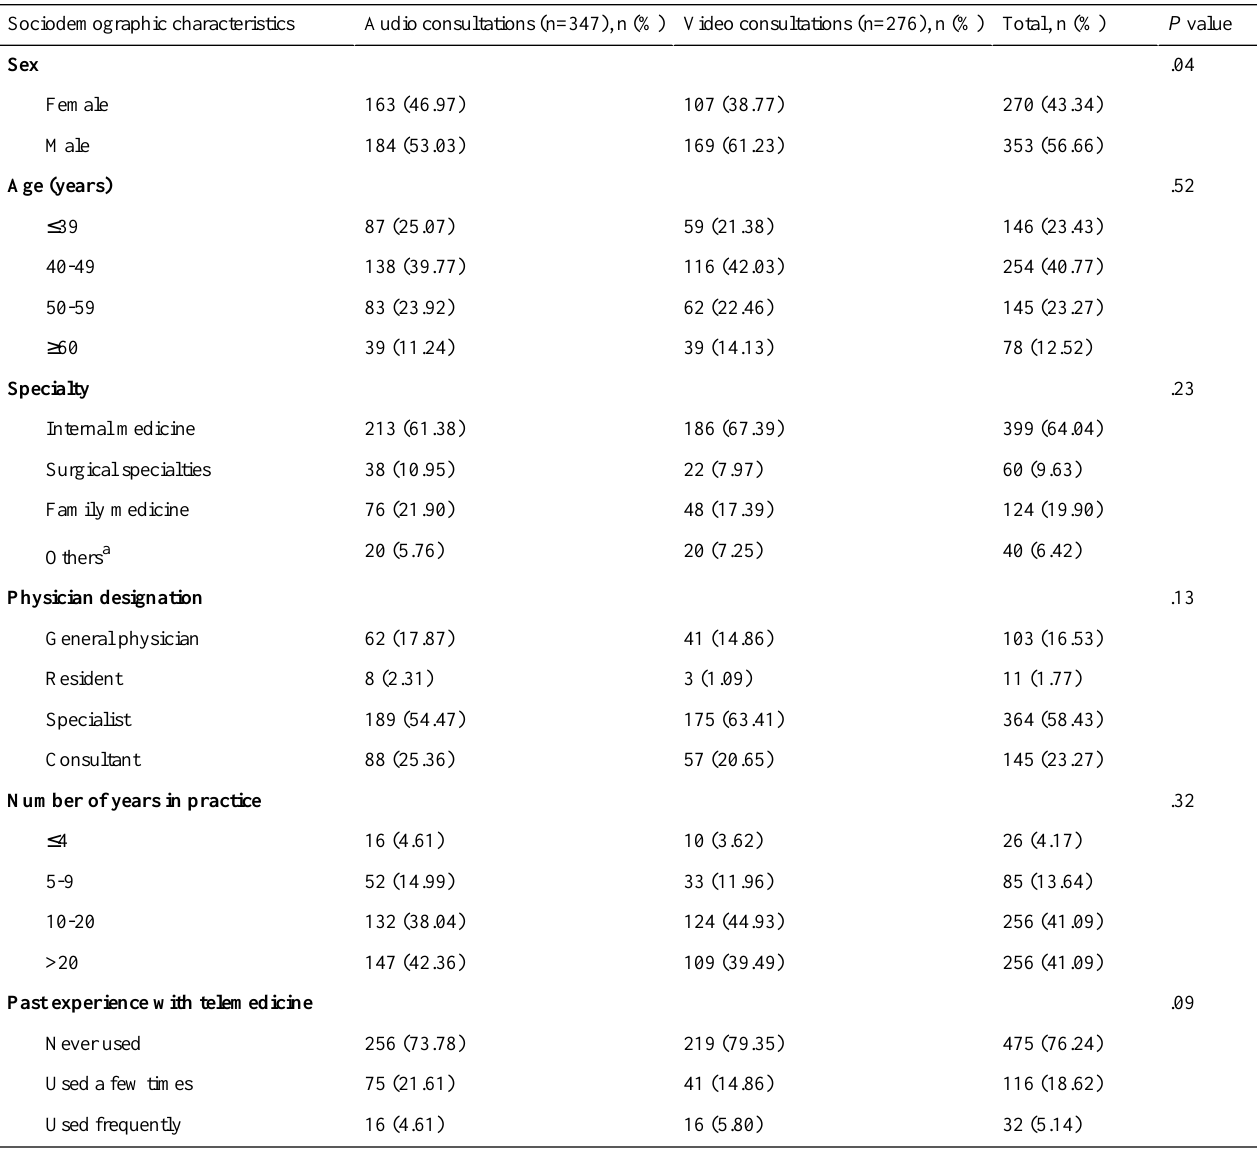
Table 1. Sociodemographic characteristics of the physicians included in the study (N=623) and descriptive statistics by